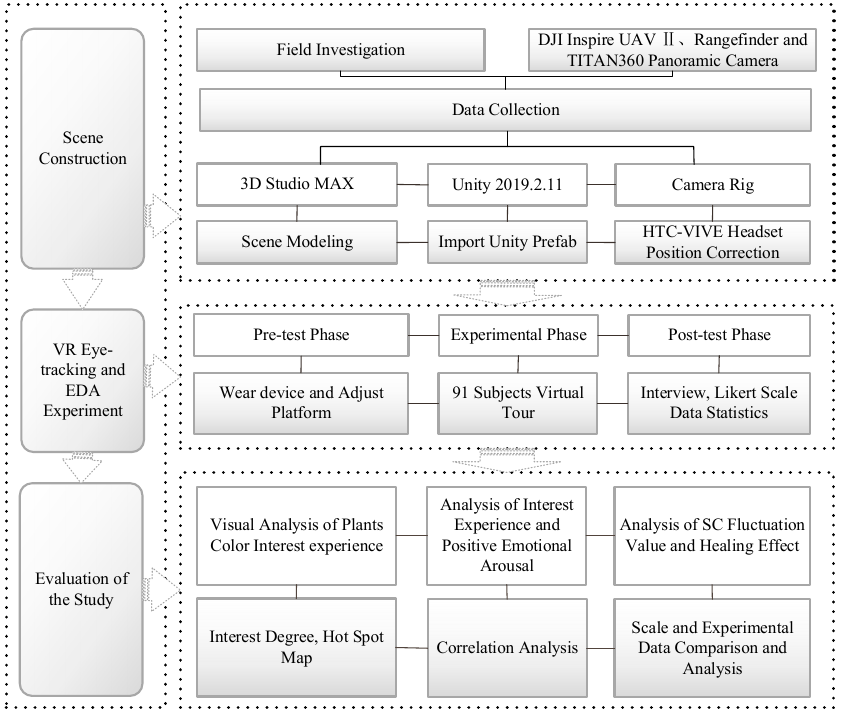
Figure 6. Reasoning diagram of landscape reconstruction design and healing effect.